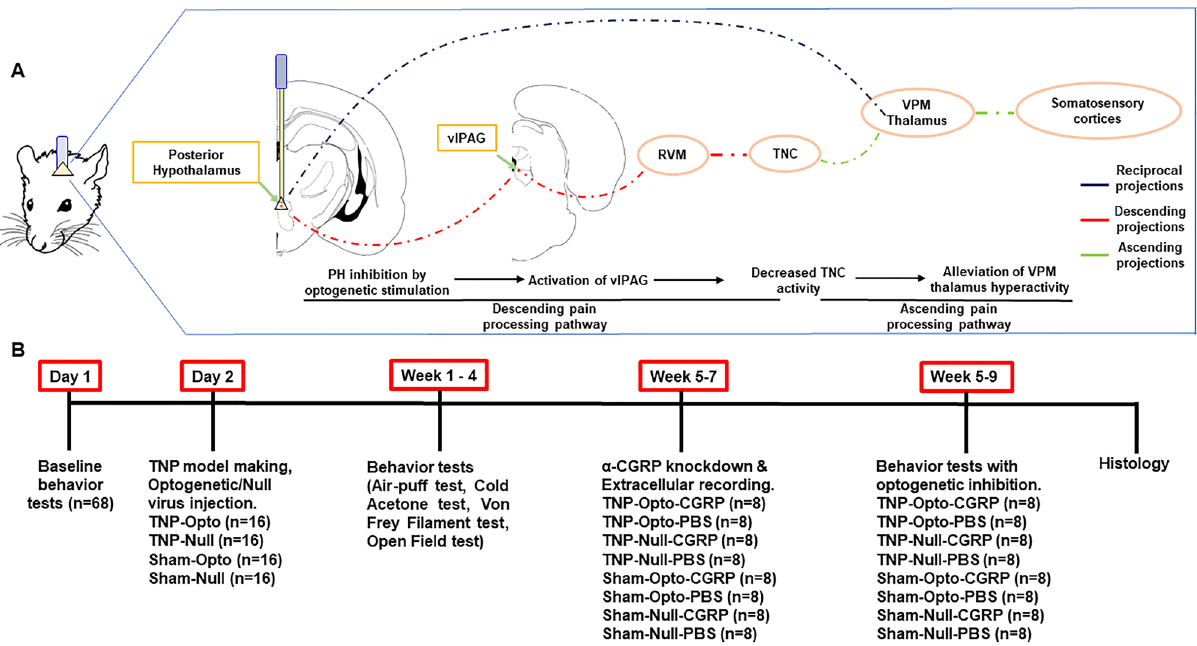
Figure 1. Targeted neural circuitry and experimental timeline. ( A ) Modulation of descending pain processing pathway by optogenetic inhibition of PH. ( B ) Experimental timeline. PH = Posterior hypothalamus; vlPAG = Ventrolateral periaqueductal gray; CCI-ION = Chronic constriction injury of infraorbital nerve; RVM = Rostral ventromedial medulla; TNC = Trigeminal nucleus caudalis; VPM thalamus = Ventral posteromedial